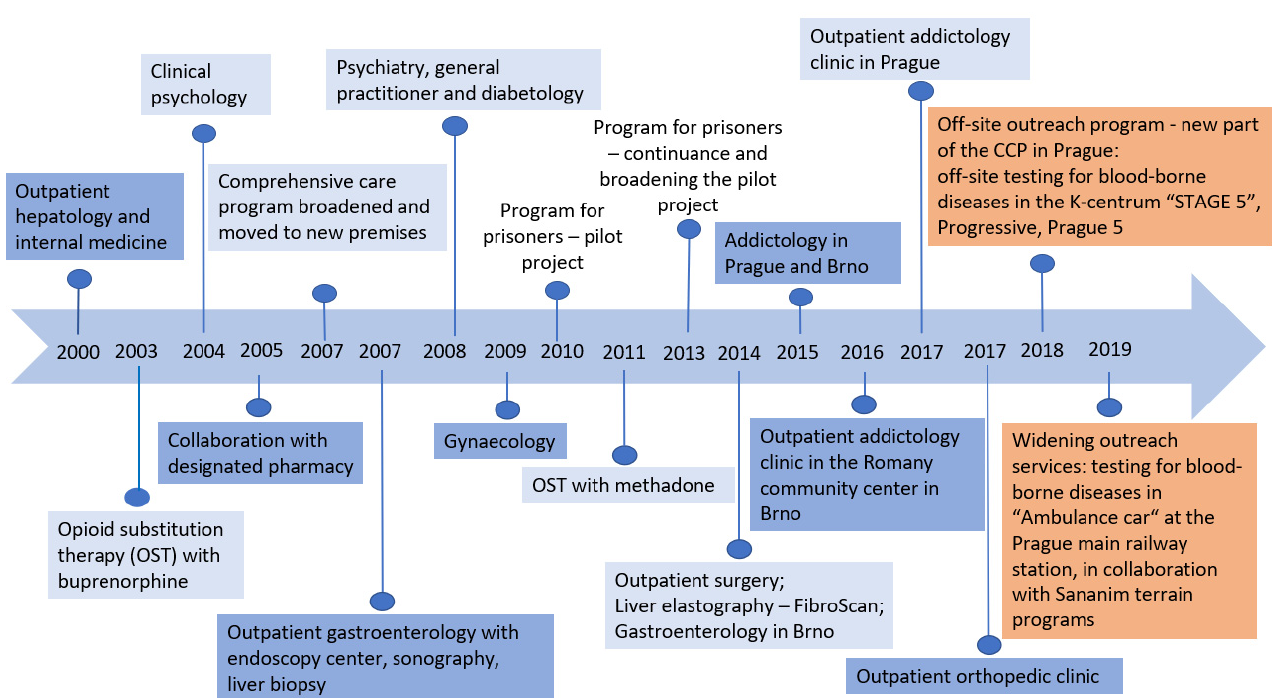
Figure 1. Development of the Comprehensive Care Program for patients with addiction comorbi- dity in the Remedis healthcare facility in Prague and Brno in the Czech Republic [16].